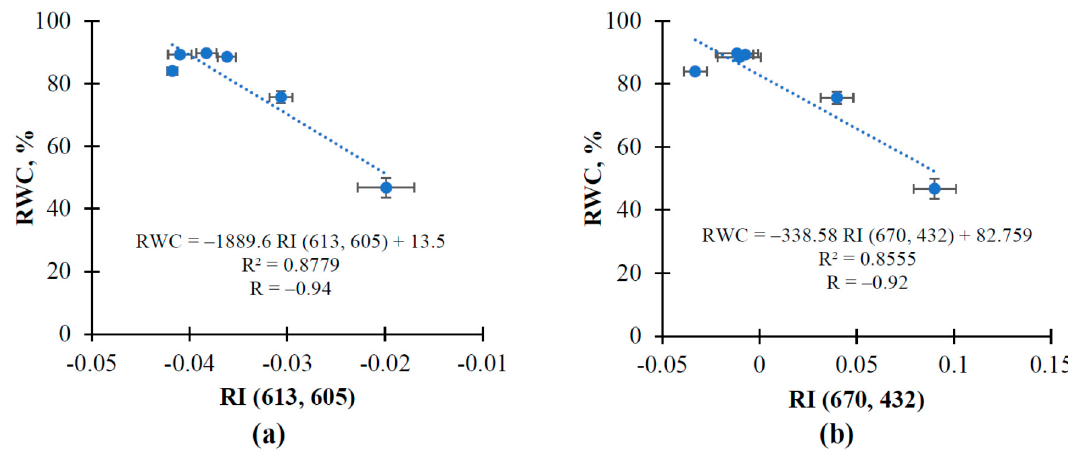
Figure 9. Scatter plots between RWC and RI (613, 605) ( a ) and between RWC and RI (670, 432) ( b ) which were measured in wheat cultivated under open-ground conditions ( n = 6). Only the side view was used for hyperspectral measurements. Corresponding averaged values from Figures 7 and 8 were used for the scatter plots. R and R 2 are correlation and determination coefficients. Correlation coefficients were significant for all variants.